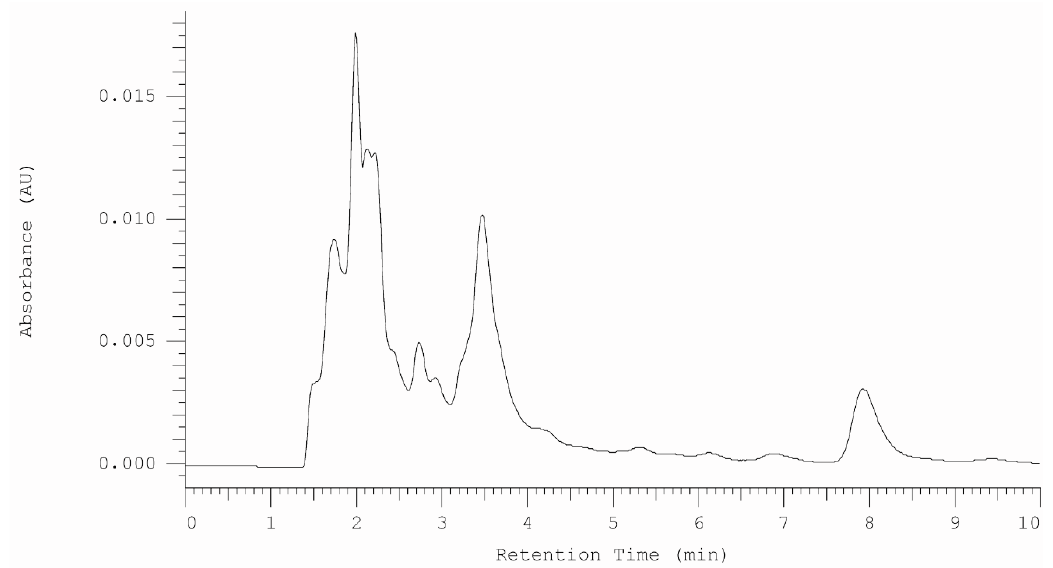
Figure 3. HPLC-DAD chromatogram obtained for urine sample from patent treated by vortioxetine. The sample was taken 24 h after drug administration.